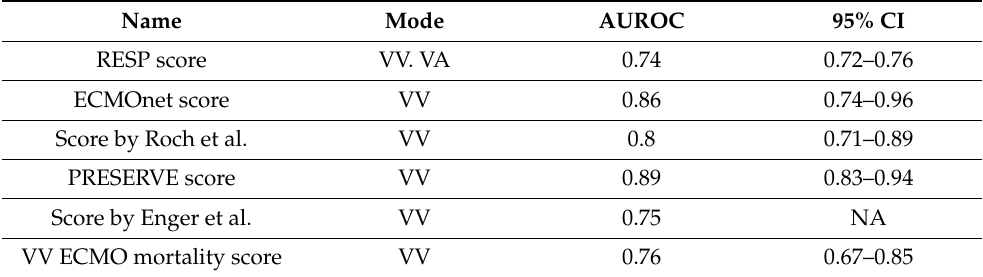
Table 4. Mortality prediction scales for patients who may undergo VV-ECMO